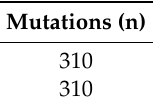
Figure 6. Isometric view of three of the best shapes generated per mesh with shape annealing algorithm for the filling application: ( a ) Structures generated with the tetrahedron mesh as the outer bounds of the design space. Each structure, from left to right, has a total length of 7595 bp, 7784 bp, and 7728 bp; ( b ) Structures generated with the snub cube mesh as the outer bounds of the design space. Each structure, from left to right, has a total length of 9275 bp, 8484 bp, and 8582 bp; ( c ) Structures generated with the Stanford bunny mesh as the outer bounds of the design space. Each structure, from left to right, has a total length of 14,595 bp, 13,531 bp, and 14,105 bp. Table 4. Shape annealing optimization parameters.